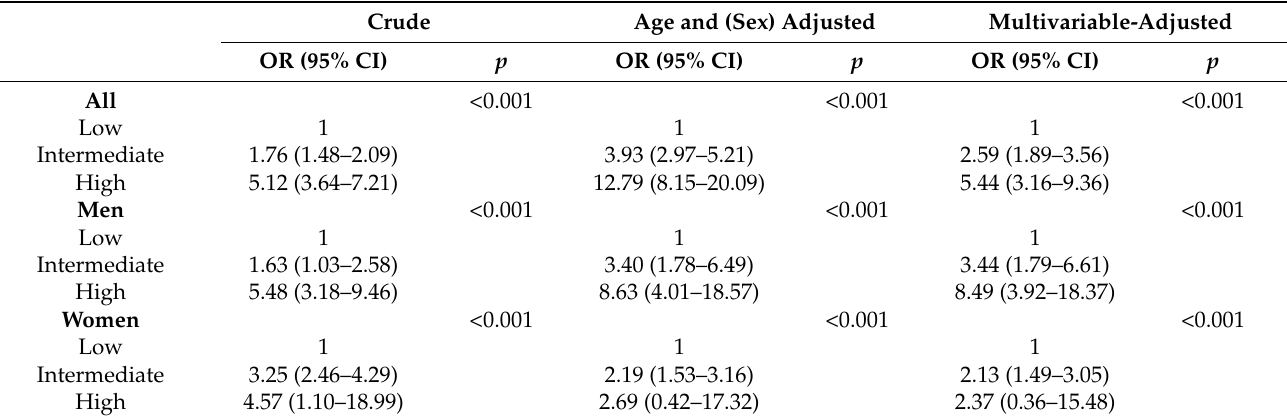
in men, the OR of NAFLD was 8.49 (95% CI: 3.92–18.37) in the high-risk group.